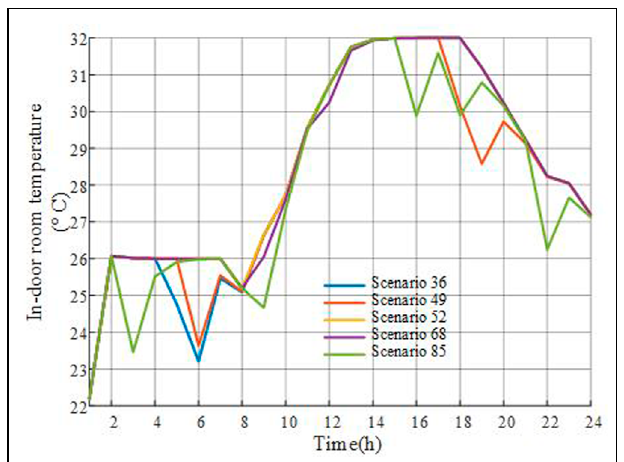
FIGURE 7 | Indoor room temperature in selected scenarios.